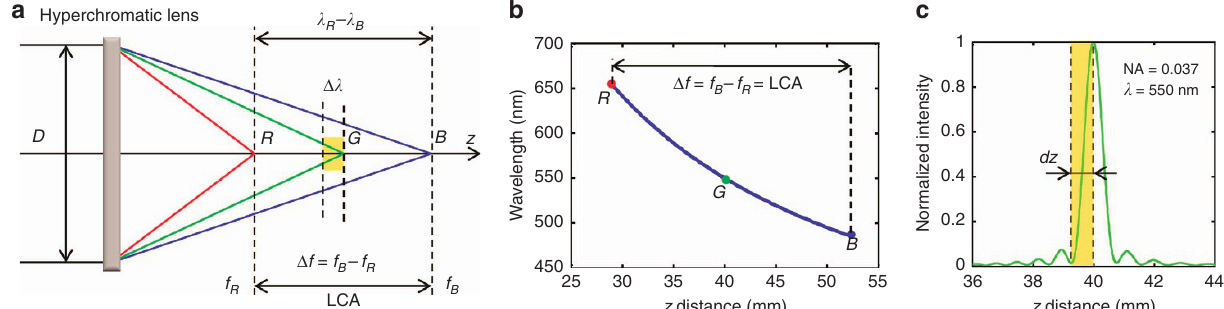
Figure 3 ( a ) Dispersion of the hyperchromatic lens with red/green/blue wavelengths focused on the optical axis z , when the lens is positioned at z = 0; ( b ) distribution of the different wavelengths on the z axis; and ( c ) the intensity distribution of a single wavelength on the z axis where dz is the distance between the peak maximum and the fi rst minimum of the